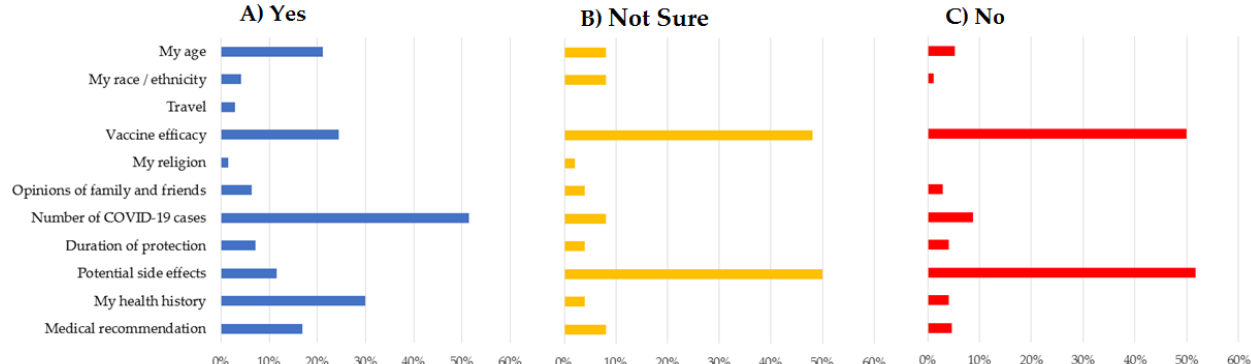
Figure 1. Reasons provided by participants regarding willingness to receive a COVID-19 vaccine. ( A ) Among participants who demonstrated willingness to get vaccinated; ( B ) among participants who were unsure about vaccination; ( C ) among participants who hesitant to take the COVID-19 vaccine.